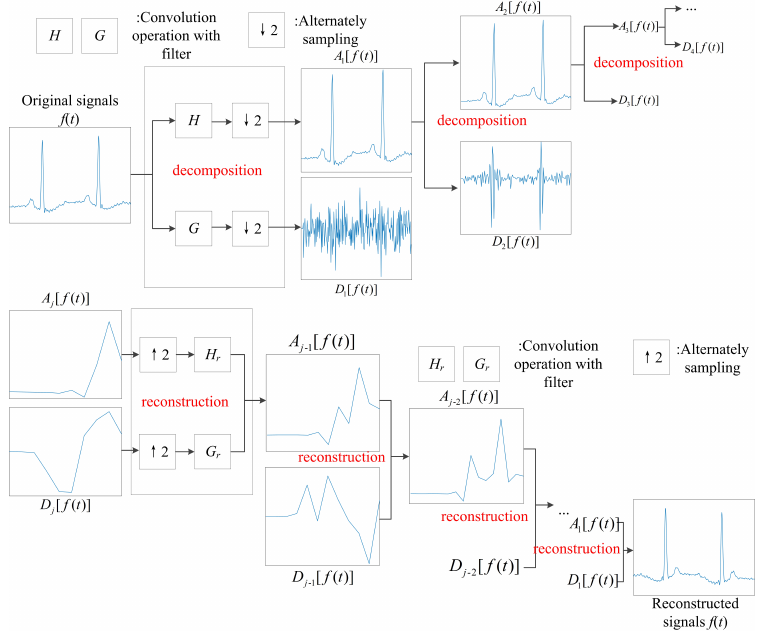
Figure 2. Diagram of wavelet decomposition and